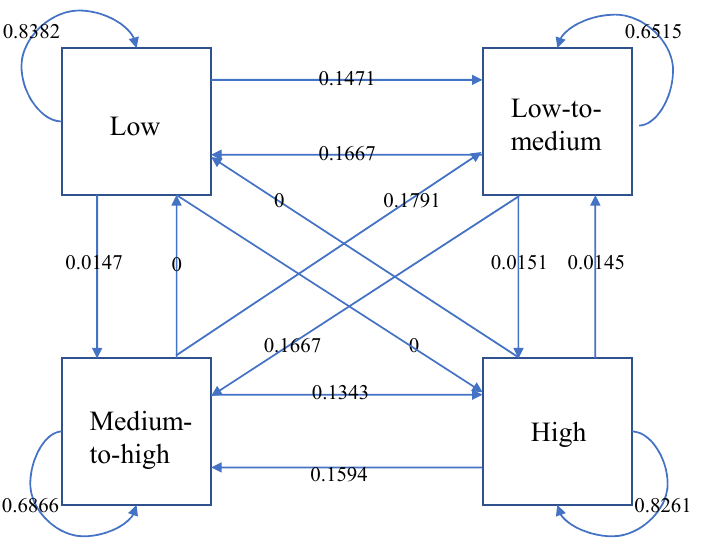
Figure 5. Markov transition matrix of the MSW treatment carbon emission efficiency in China during 2010–2019.